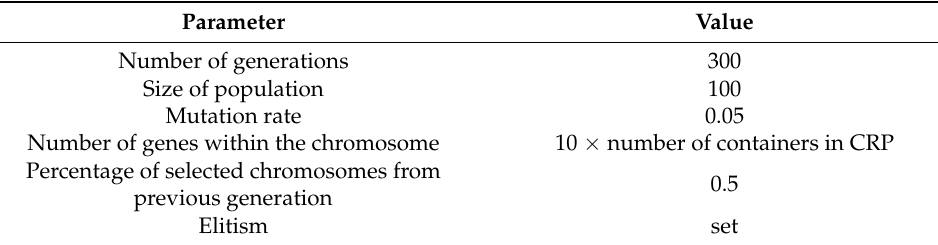
Table 1. The genetic algorithm setup for resolving